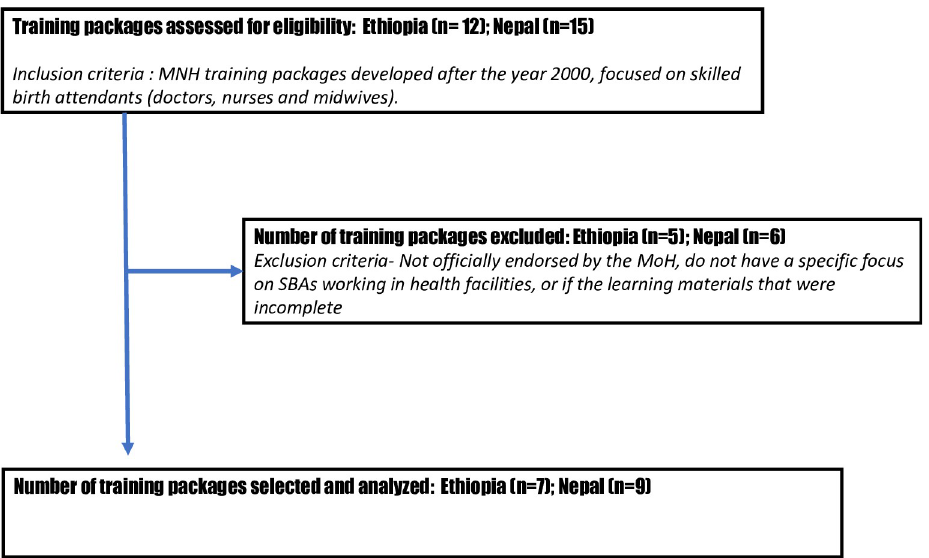
Fig 1. Flowchart showing steps for auditing the training materials in Ethiopia and